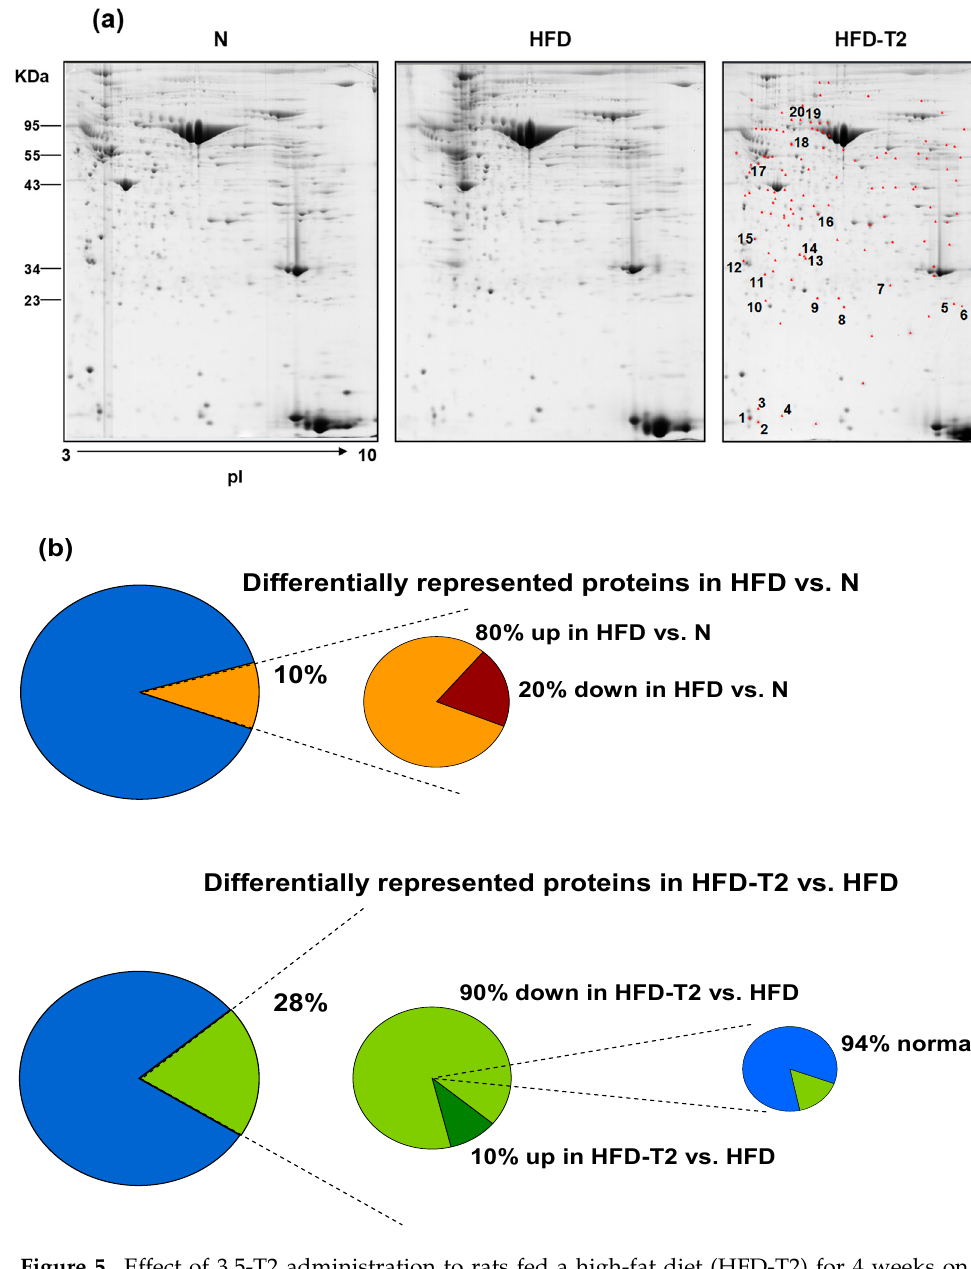
Figure 5. Effect of 3,5-T2 administration to rats fed a high-fat diet (HFD-T2) for 4 weeks on VAT protein repertoire. ( a ) Representative 2D-E Coomassie Blue stained maps of total VAT soluble proteins extracted from N, HFD and HFD-T2 rats. Proteins were resolved on 17 cm/pH 3–30NL IPG strips in the first dimension and on 12% T SDS-PAGE in the second one. Identified proteins among those with a density that differed significantly (by at least 0.5-or 2-fold; p < 0.05) between HFD-T2 and HFD (in red) are numbered. Spot numbers refer to Supplementary Tables S1 and S2. ( b ) Percentages of affected (differentially represented, over-represented, and down-represented) protein spots with respect to the total ones studied in the VAT proteome (406 protein spots) in the comparisons: HFD vs. N and HFD-T2 vs. HFD.